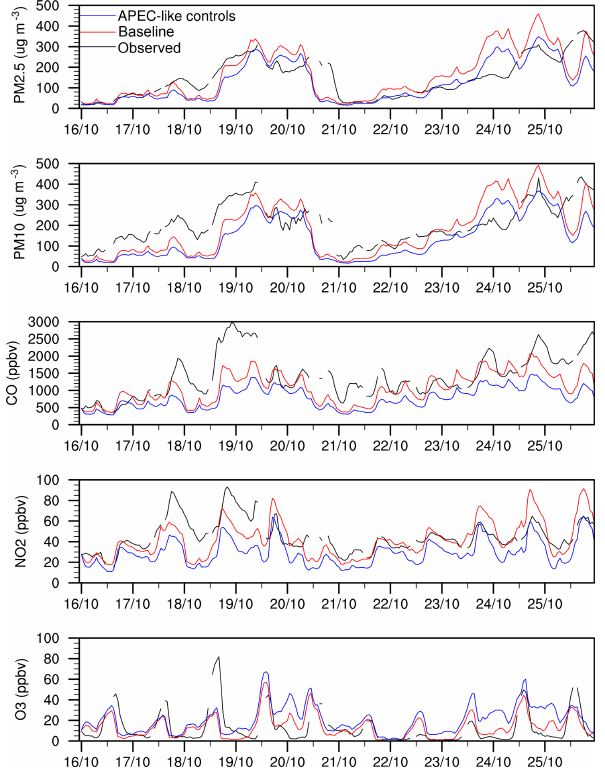
Figure 9. Time series of surface pollutants averaged over the 12 measurement stations in Beijing during 16–25 October